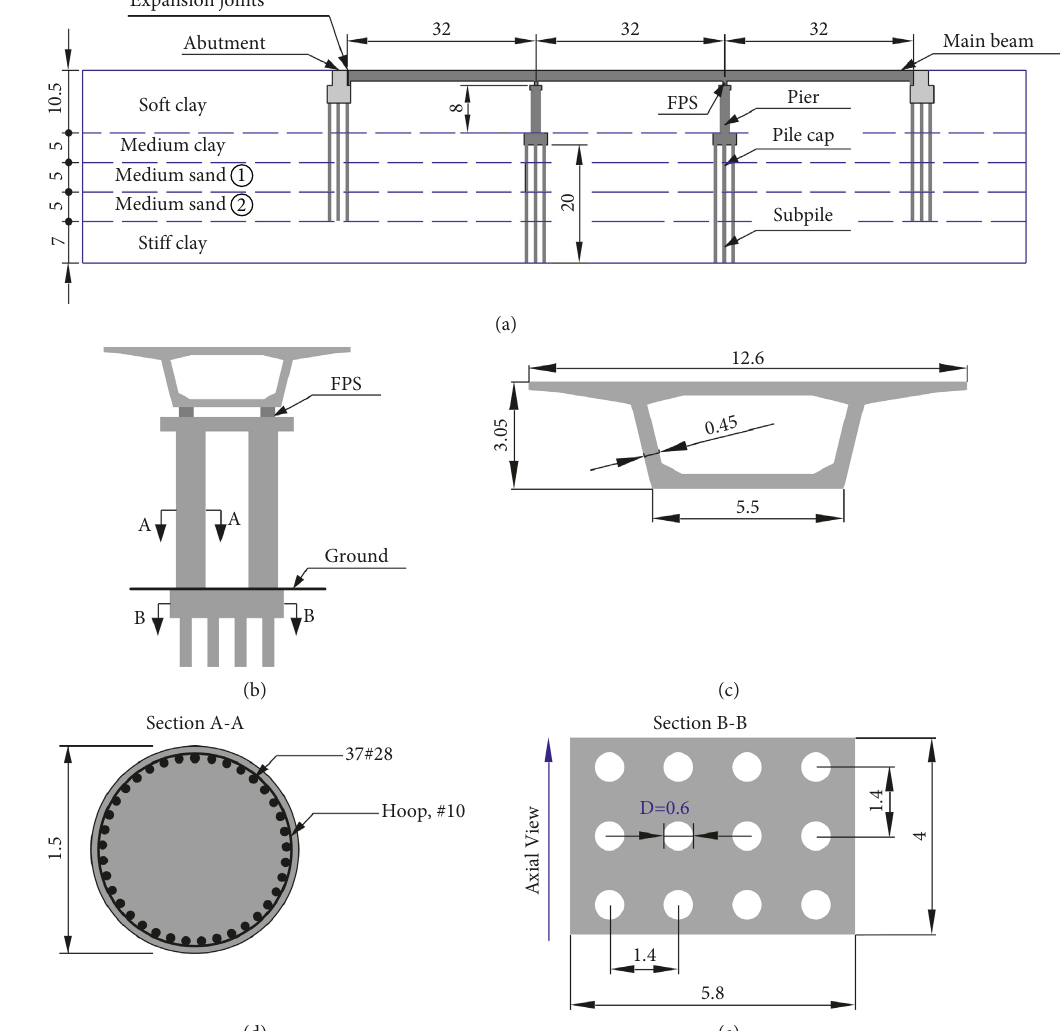
Figure 1: The configuration of typical concrete continuous bridge. (a) Side view of the bridge elevation and four-layer soil profile. (b) Axial view of the bridge structures. (c) Cross section of the main beam. (d) Cross section of a single pier. (e) Cross section of the pile cap and 12 subpiles. Dimensions are in